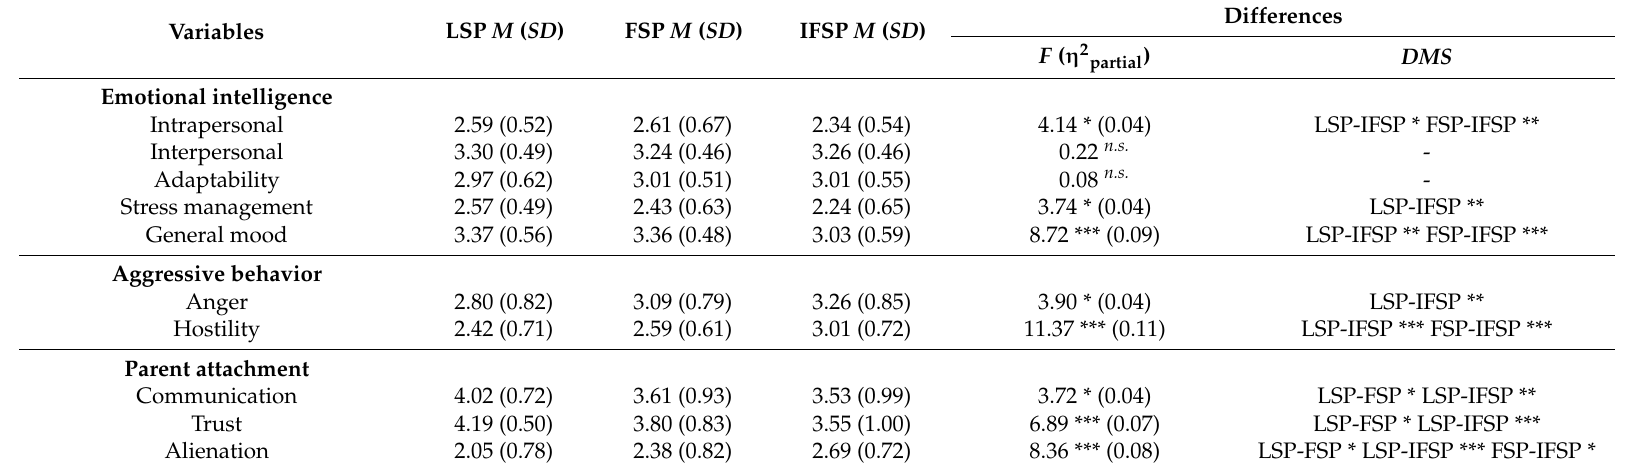
Table 2. Emotional Intelligence, Aggressive Behavior, and Parent Attachment by Stress